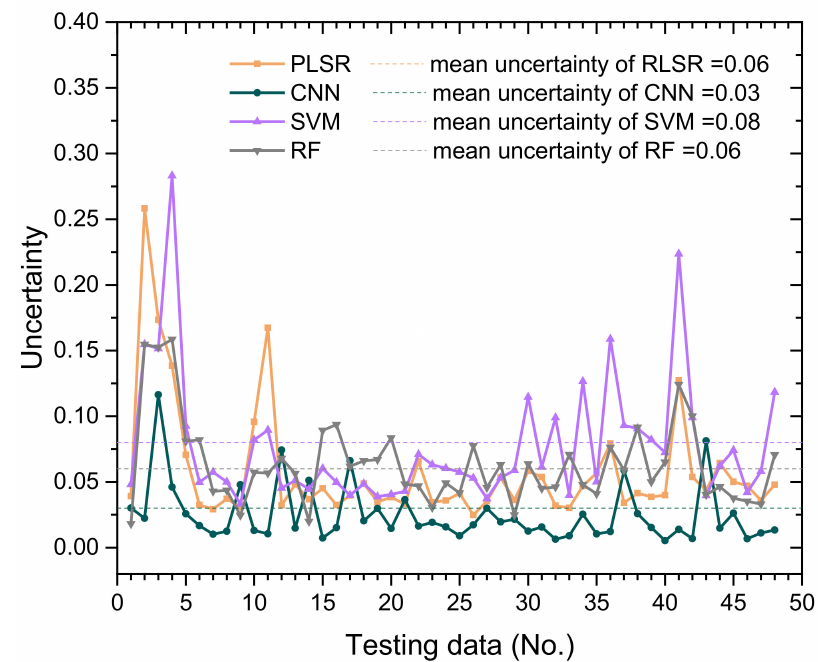
Figure 3. Uncertainty value of 48 testing points.